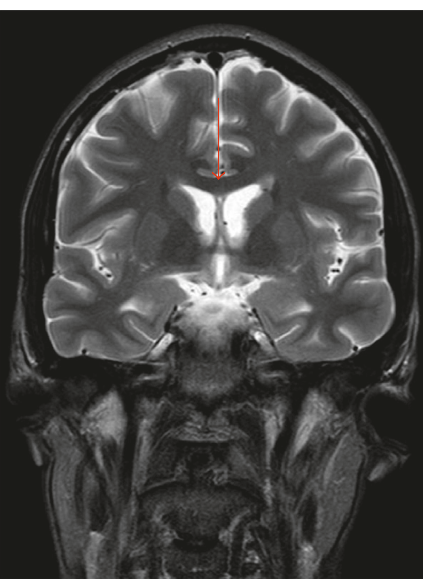
Figure 1: Ventricular hypersignal in cranial MRI (FLAIR), sug- gestive of